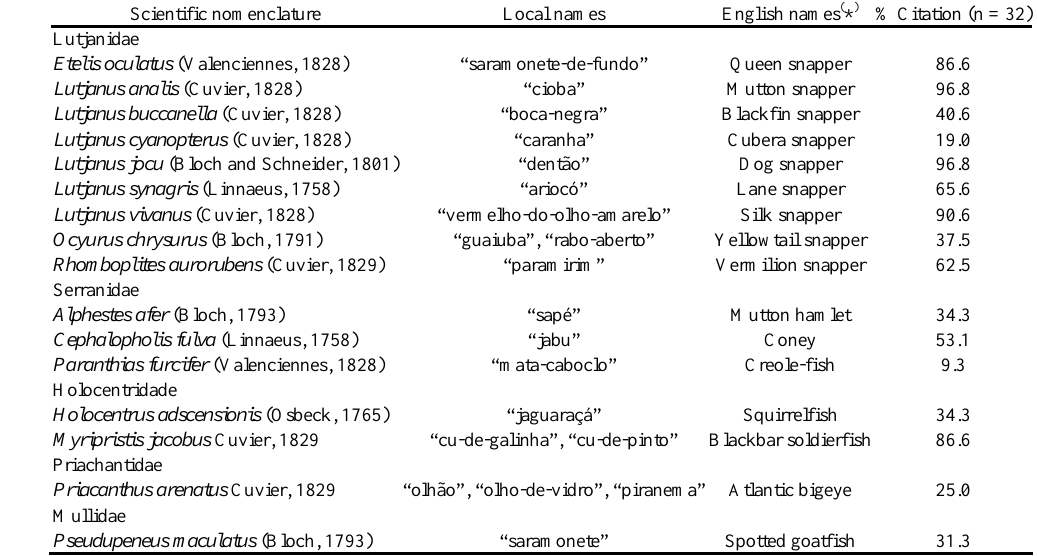
Table 1. Species belonging to the snapper group according to the fishermen studied and the percentage of quotations by the handmade fishermen from Ilhéus, Bahia State, Brazil. (*) According to Froese & Pauly